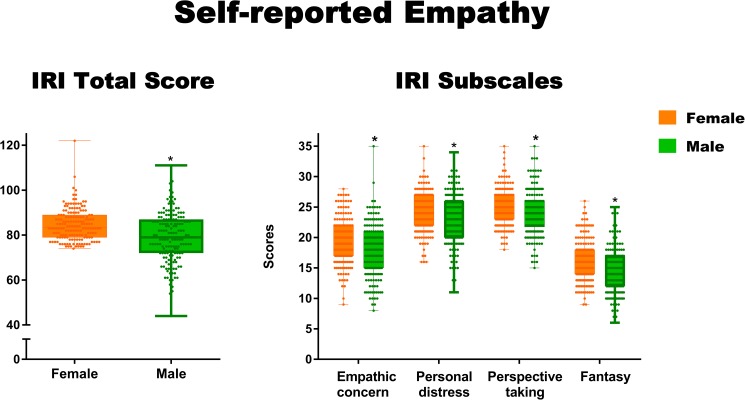
Significant sex differences in self-reported empathy.Asterisks indicate significant differences (p < .05). Differences with a small or higher effect size (η2 ≥ 0.01) are marked with a bold border.